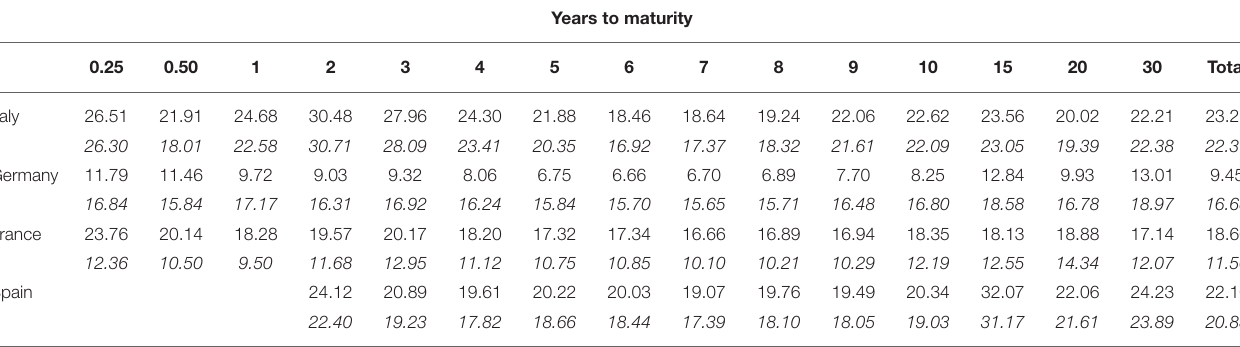
TABLE 2 | Calibration error of the 2-factor Vasicek model.